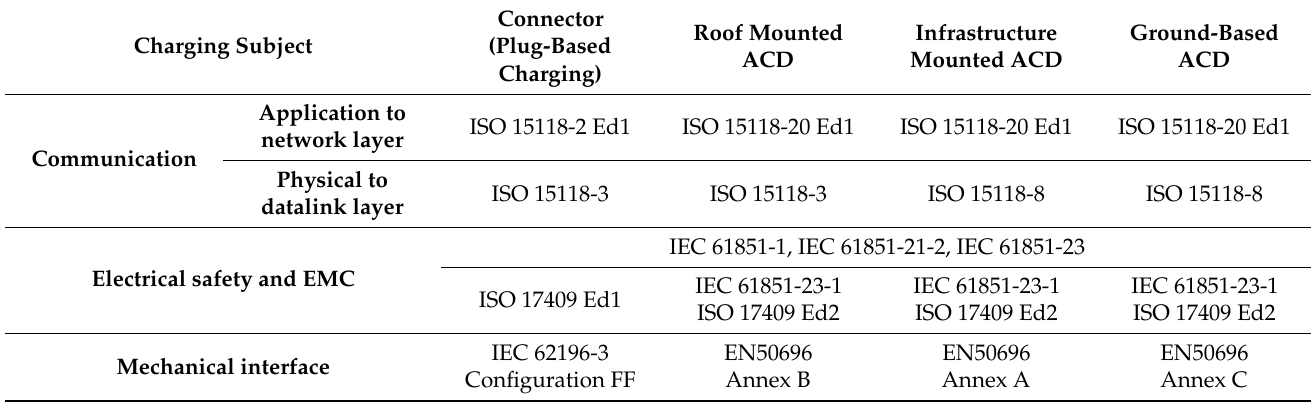
Table 3. CEN-CENELEC recommendations for conductive charging of HD-EVs. Standards